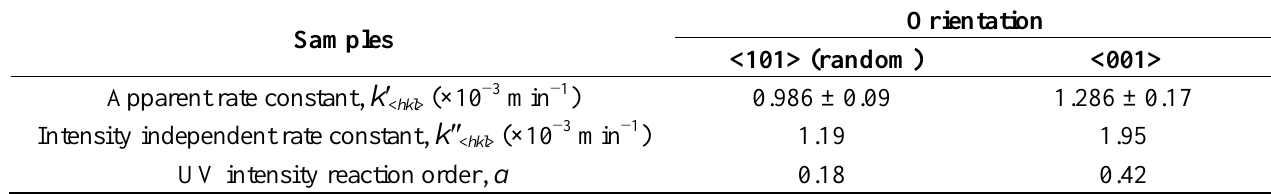
Table 2. Kinetic parameters for the photocatalytic degradation of MB for the samples with <001> preferential orientation, and with dominant <101> orientation (randomly oriented